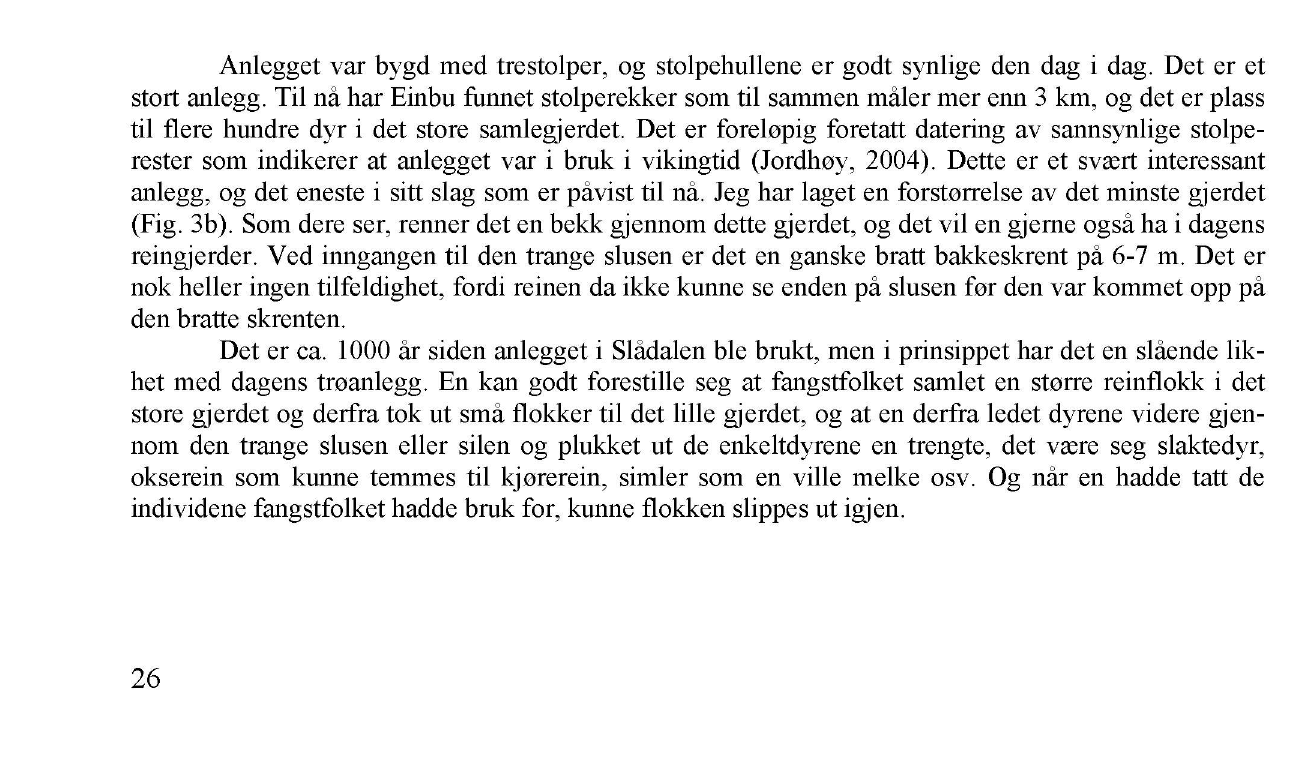
Fig. 3 a. Skisse av et fangstanlegg på Verket i Nord-Gudbrandsdal med fangarmer (ledegjerder) "beitehage" og mindre samlegjerde med "sil". Tegnet etter mål og skisser fra Tor Einbu (2001), og egen befaring av anlegget sammen med Einbu i